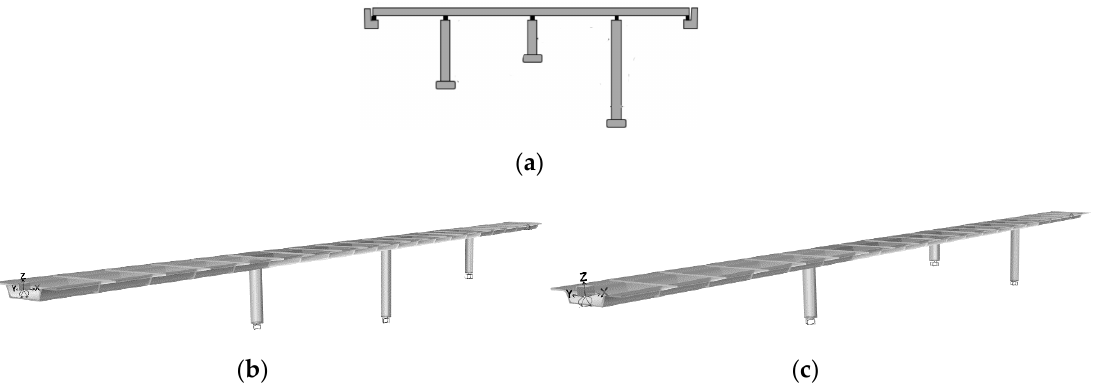
Figure 9. ( a ) Bridge structural model, ( b ) SAP 2000 model of the regular bridge and ( c ) SAP 2000 model of the irregular bridge.